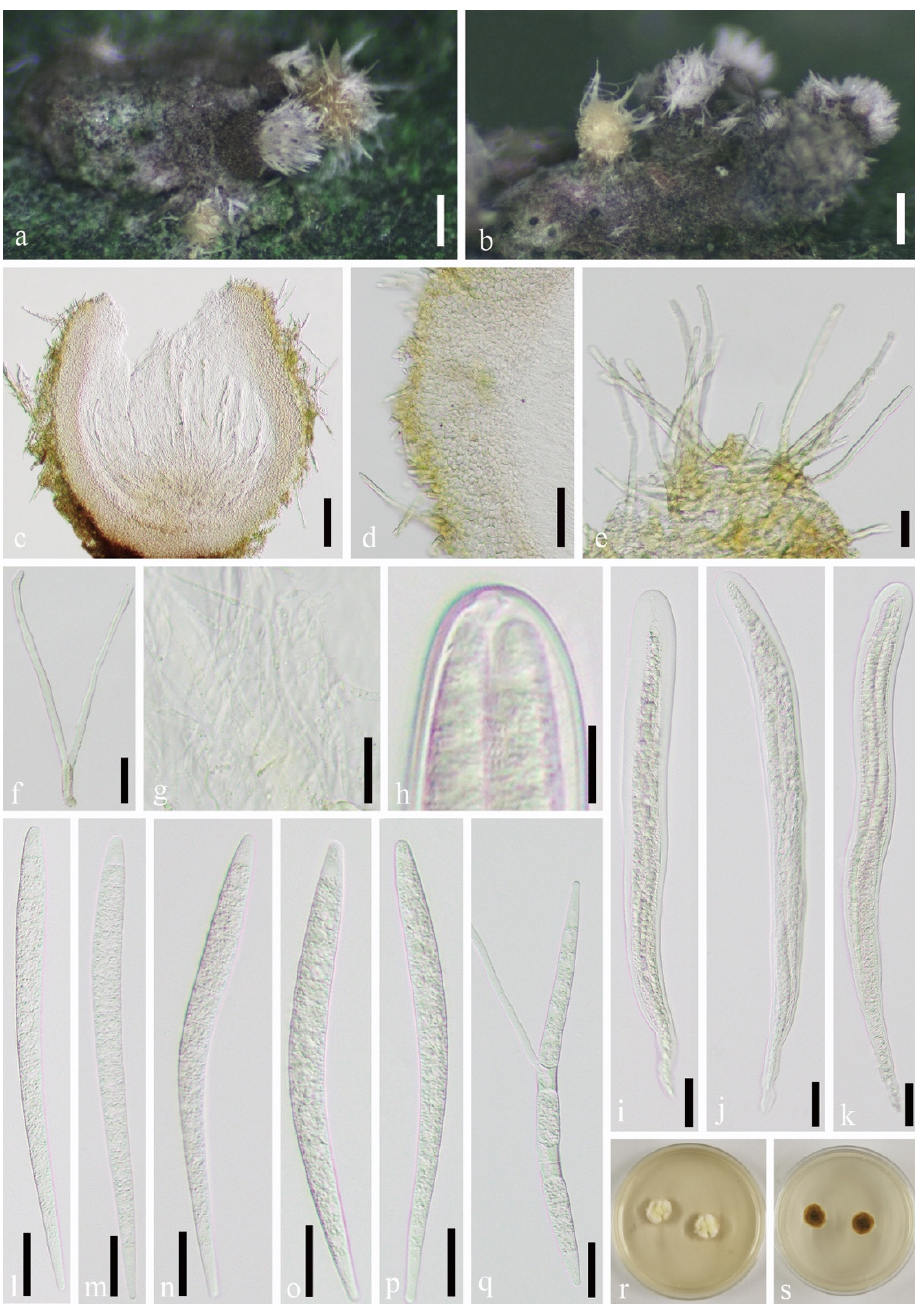
Figure 3. Podonectria novae-zelandiae (SICAU 21-0005). ( a , b ) Ascomata and sporodochia on host substrate. ( c ) Section through ascoma. ( d ) Peridium. ( e , f ) Hairs covering on ascoma. ( g ) Pseudoparaphyses. ( h ) Ocular chamber. ( i – k ) Asci. ( l – p ) Ascospores. ( q ) Germinated ascospores. ( r , s ) Colonies on PDA after 18 days. Scale bars: ( a , b ) 200 μ m, ( c ) 100 μ m, ( d ) 50 μ m, ( e – g ) 20 μ m, ( h ) 10 μ m, ( i – q ) 20 μ m.